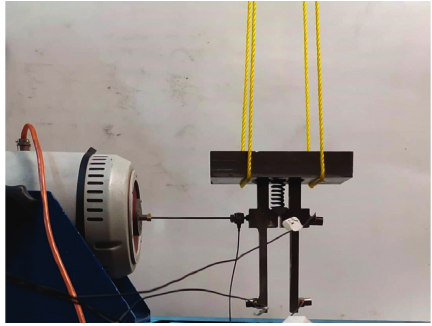
Figure 5: Experimental setup suspension configuration and sensor attachments configuration.